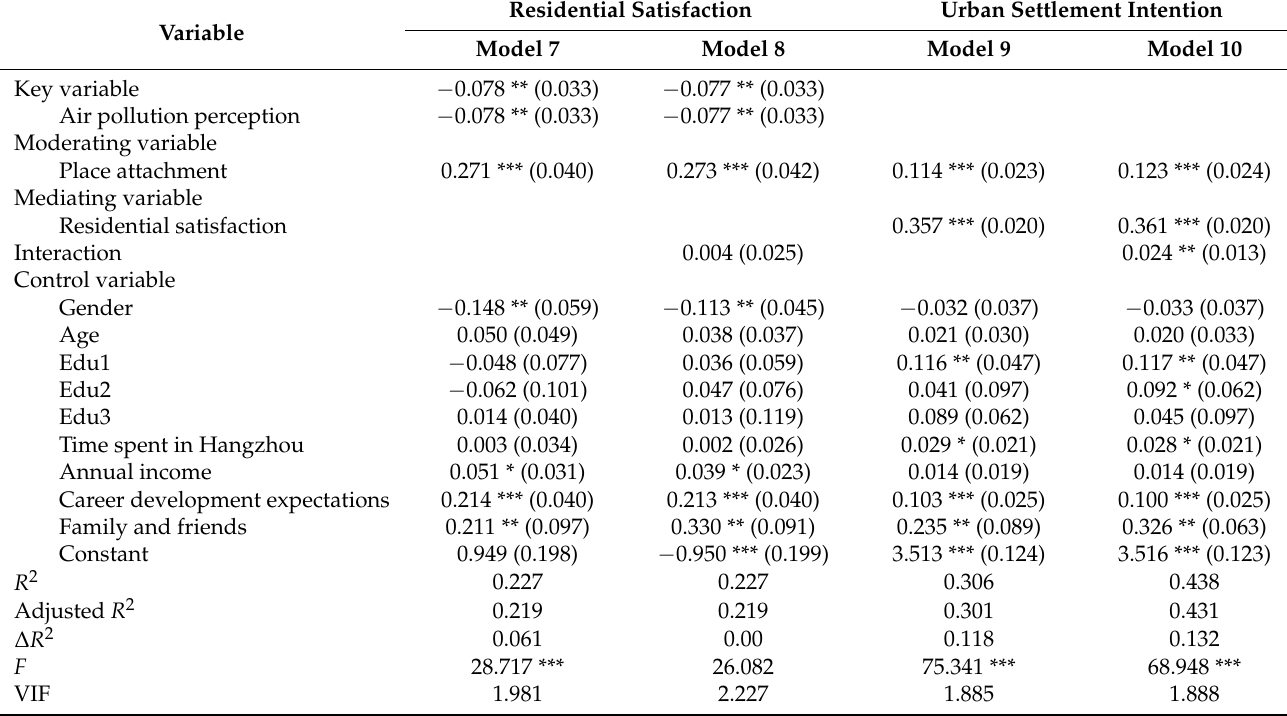
Table 4. Testing the moderating effects of place attachment.